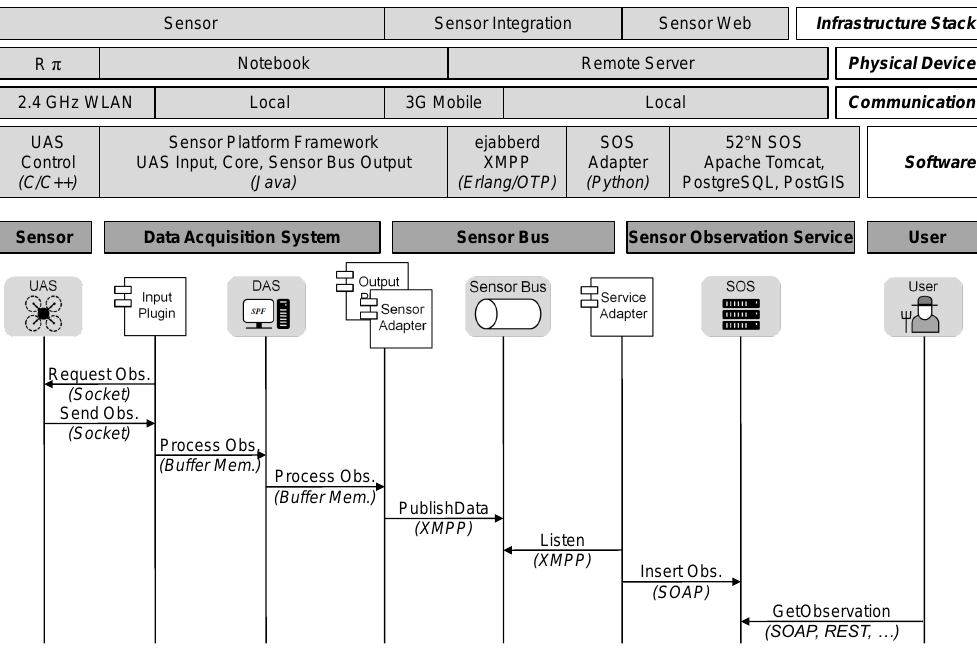
Figure 5. Sequence diagram of the processing of an exemplary UAS observation from acquisition to storage on an Internet-connected SOS (lower half). The upper half gives information about the realization of the different components of the